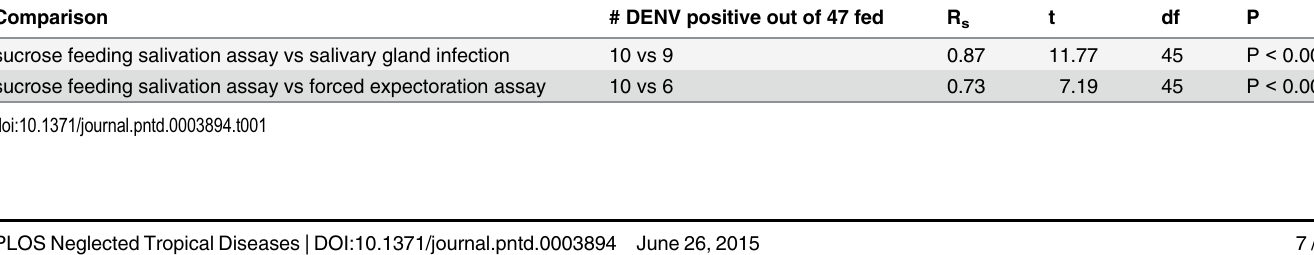
Table 1. Summary data and Spearman ’ s correlation for sucrose feeding salivation validation assay.